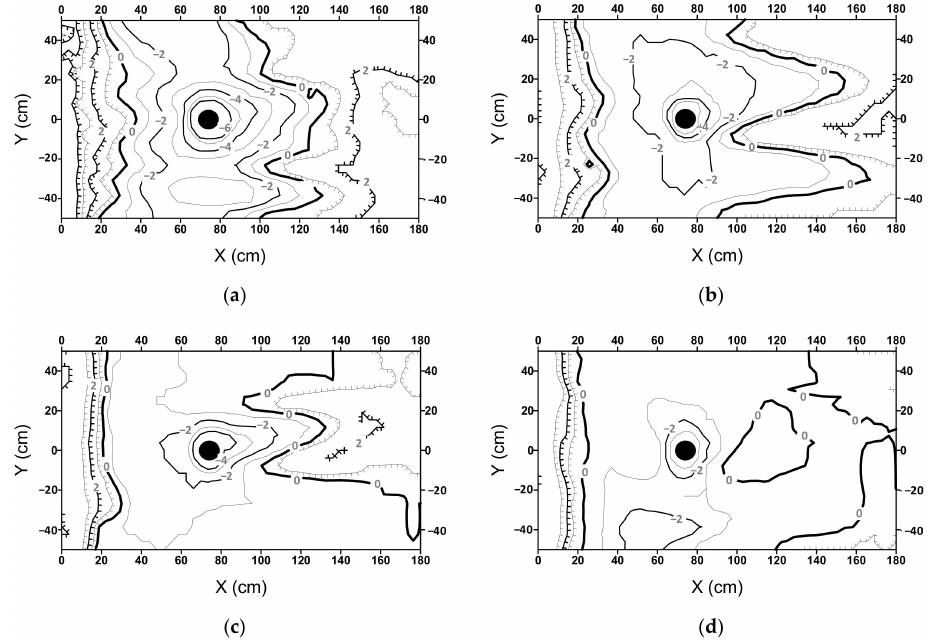
Figure 14. Sand bed changes due to different lengths of strips (the erosion and deposition contour is 1 cm; a negative value means erosion). ( a ) Case 2: D a = 1 mm, L = 25 cm; ( b ) Case 5: D a = 1 mm, L = 37.5 cm; ( c ) Case 6: D a = 1 mm, L = 50 cm; ( d ) Case 7: D a = 1 mm, L = 75